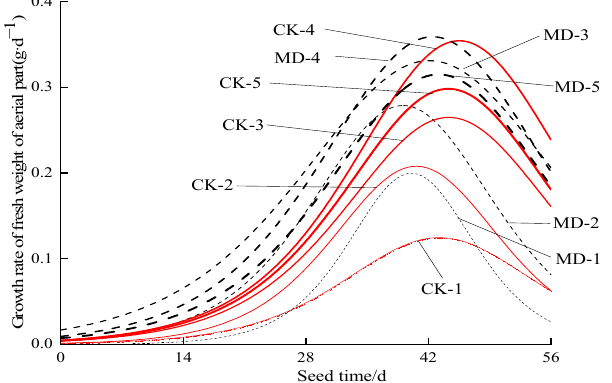
Figure 3. Daily growth rate of the fresh weight of the aerial part of spinach under different treatments.CK-1, CK-2, CK-3, CK-4, and CK-5 indicate that the soil moisture content is controlled at 45–55%, 55–65%, 65–75%, 75–85%, and 85–95% of the field capacity with conventional water, respectively; MD-1, MD-2, MD-3, MD-4, and MD-5 indicate that the soil moisture content is controlled at 45–55%, 55–65%, 65–75%, 75–85%, and 85–95% of the field capacity with magnetoelectric water, respectively.